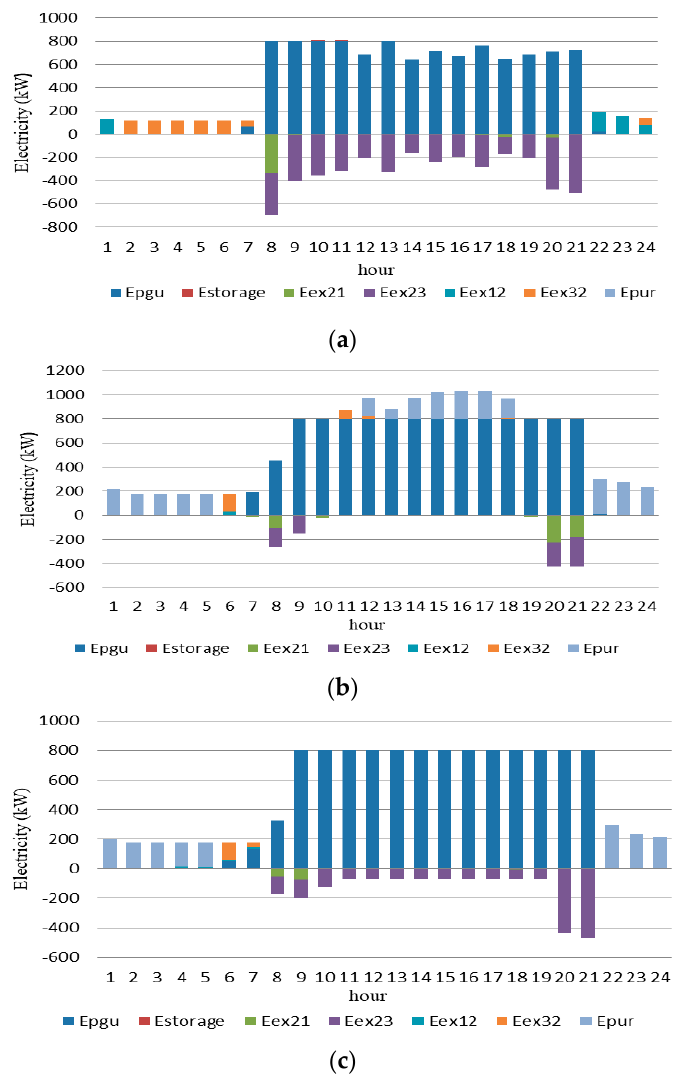
Figure 7. Hourly electricity balance of office in typical winter ( a ), summer ( b ) and mid-season days ( c ).